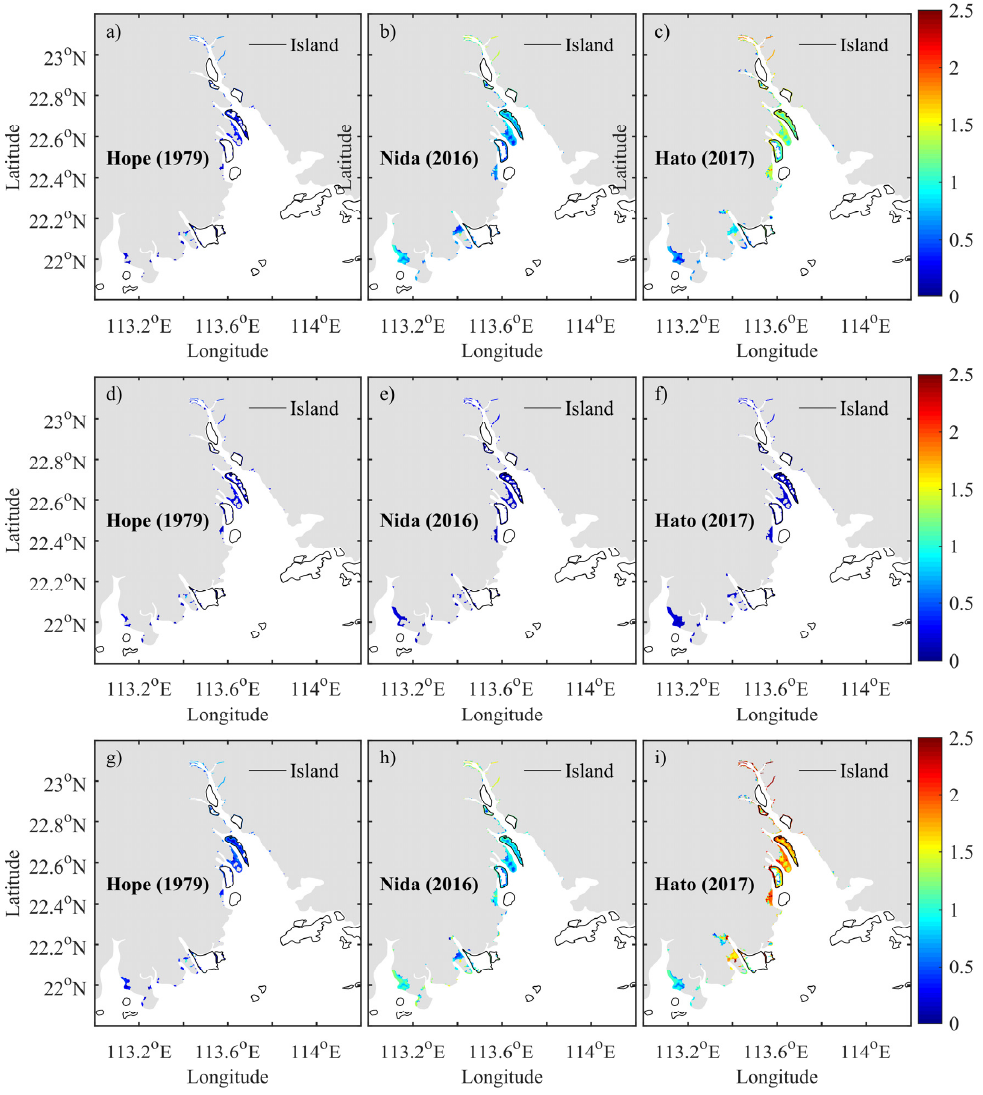
Figure 8. The inundation (units: m; shaded) maps at the PRE based on the simulation results of di ff erent forcing fields. ( a – c ): only wind forcing; ( d – f ): only pressure forcing; ( g – i ): wind-pressure forcing. The color bars of the 9 sub figures are all in the range of 0 m–2.5 m and displayed in rainbow color.